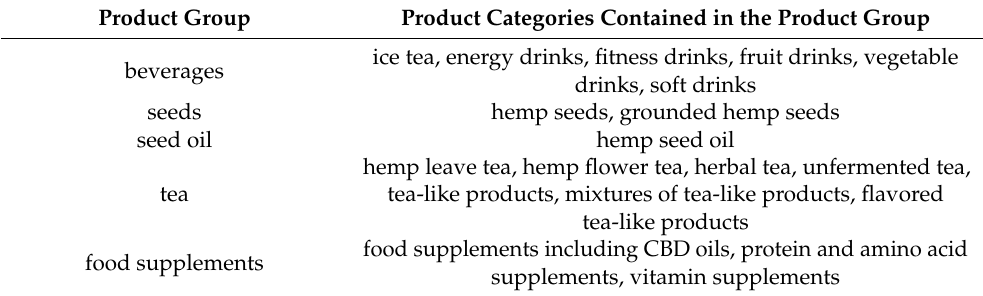
Table 1. Overview of the different products of the product groups hemp beverages, hemp seeds, hemp seed oils, hemp tea, and hemp food